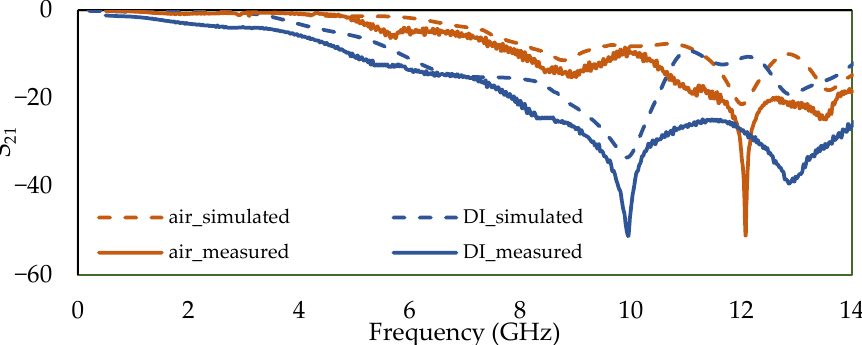
Figure 7. HFSS model of our proposed microwave-based microfluidic sensing device.